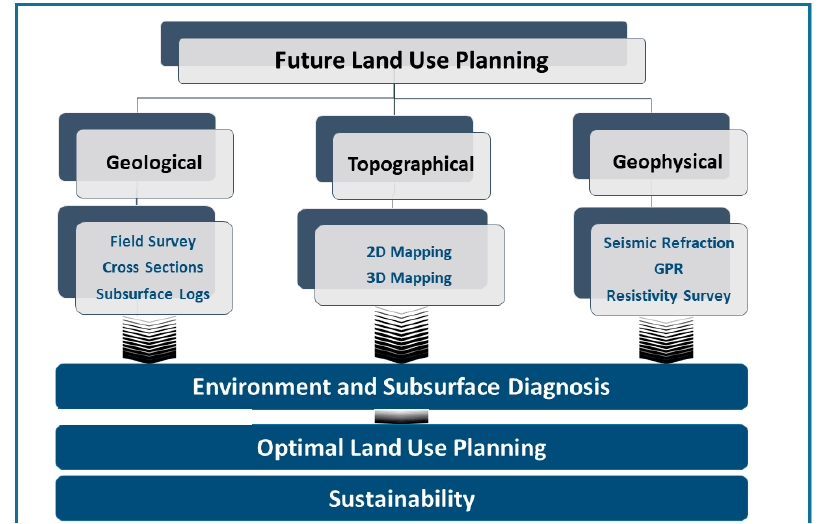
Figure 5. Applied methodology for preparing the land-use plan of the investigated site.